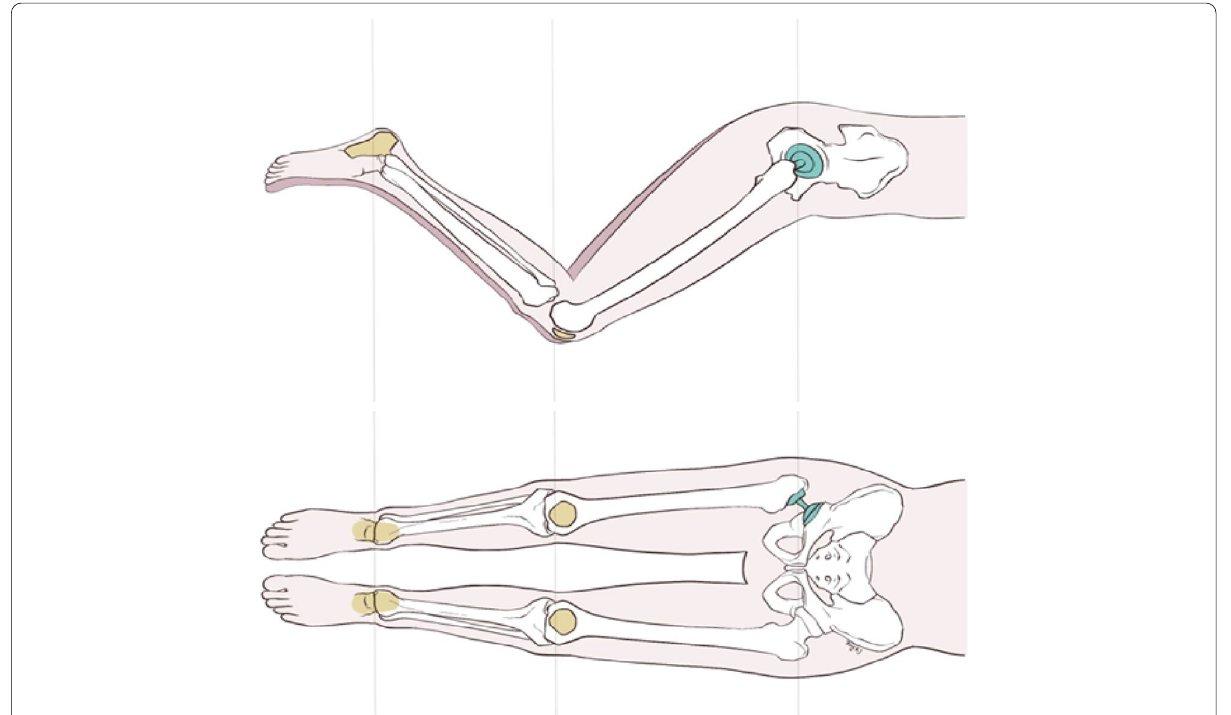
Fig. 2 Intraoperative adjustment of lower limb length by palpation of the two poles of the patella